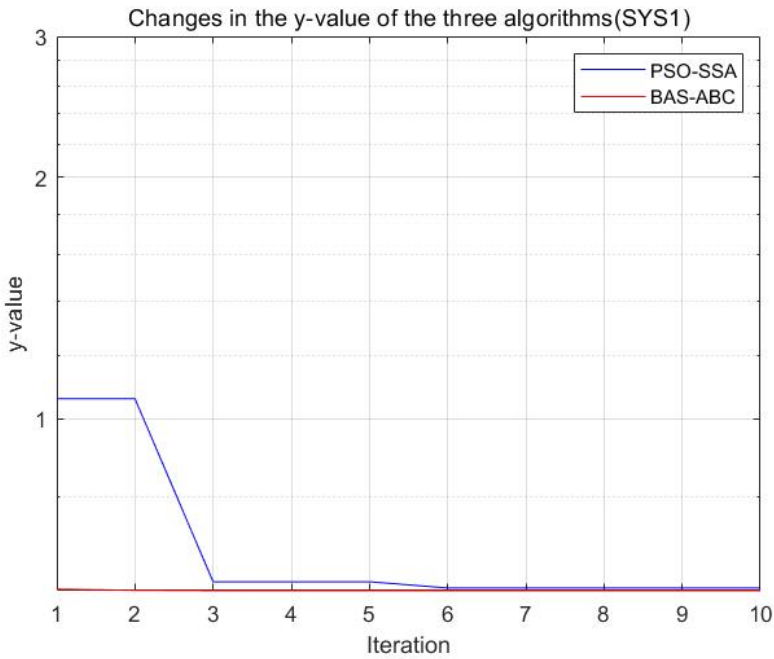
Figure 23. Changes in the 𝑦 value of the two algorithms (SYS1).